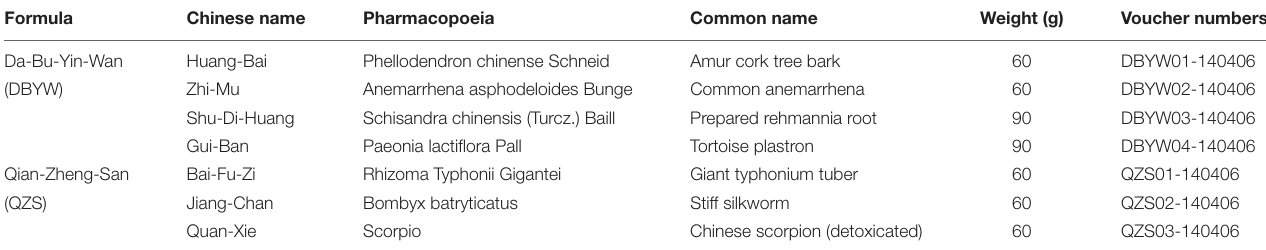
TABLE 1 | Components of Da-Bu-Yin-Wan and Qian-Zheng-San. Formula